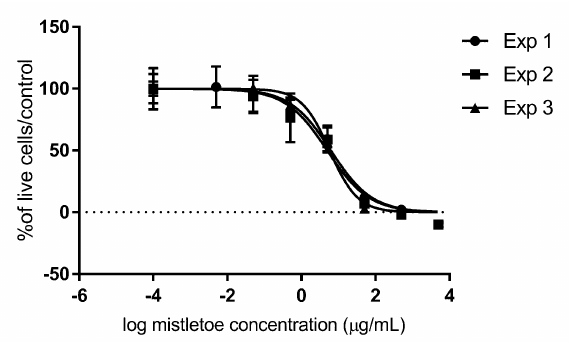
Figure 1. In vitro cytotoxic effects of Viscum album Iscucin ® Tiliae on canine SDT-3G glioma cells. Cells were exposed to a range of concentrations of mistletoe extract (5 µ g/mL, 2.5 ng/mL, 1 ng/mL, 1 pg/mL, and 0.1 pg/mL) and incubated for 72 h before cell viability was evaluated with MTT assays, which is represented as a percentage of viable cells in the treatment group as compared to untreated control cells. “Exp 1, 2, 3”means experiment 1, 2,